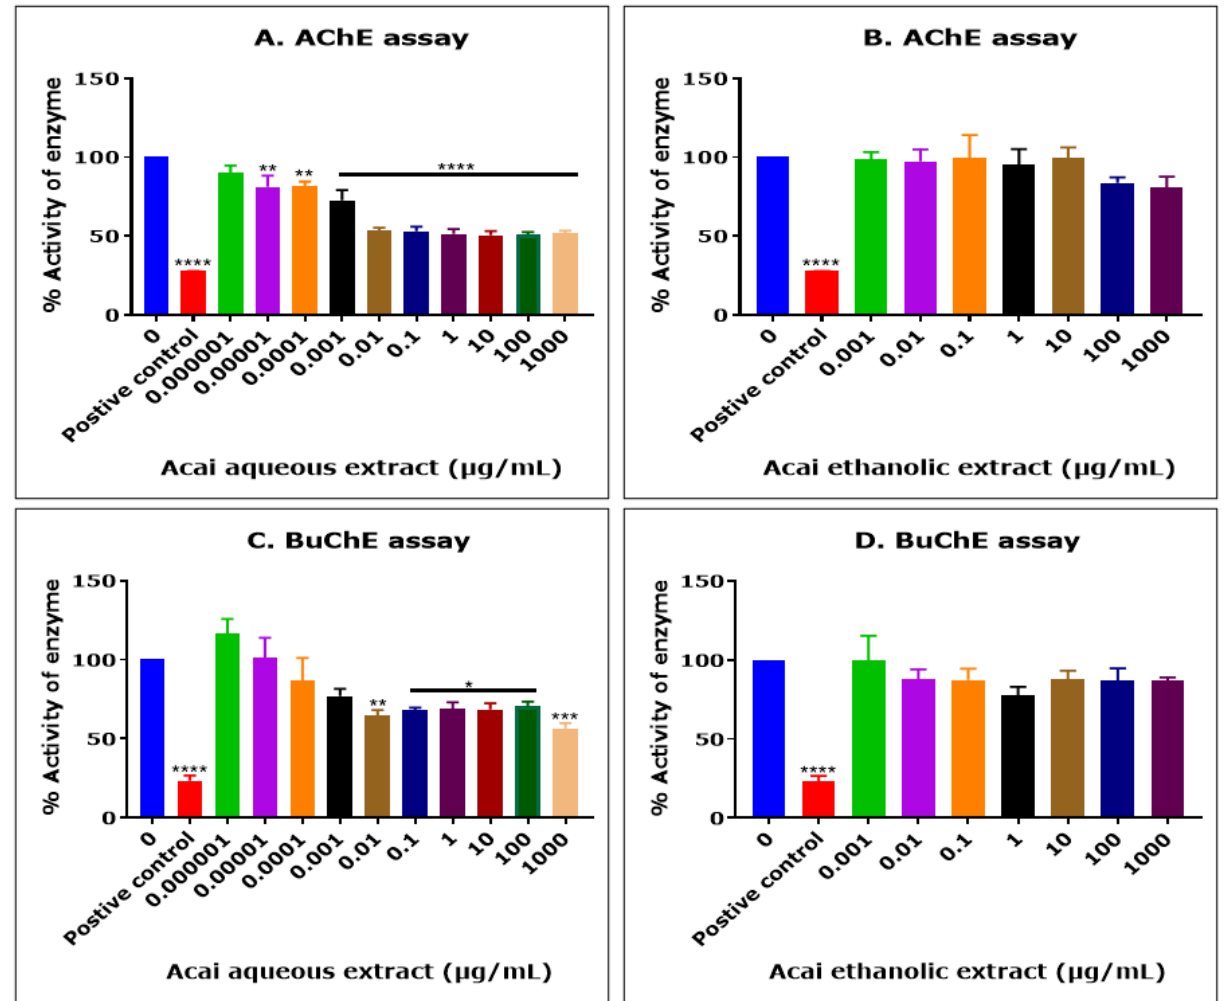
Figure 1. Cholinesterase inhibition by acai aqueous and ethanolic extracts. AChE inhibitory activity of acai aqueous extract ( A ) and acai ethanolic extract ( B ). BuChE inhibitory activity of acai aqueous extract ( C ) and acai ethanolic extract ( D ). Histograms represent means ± SEM for at least three replicate assays at each extract concentration ( n = 6). For the positive control inhibitors, 5 mM azamethiphos and 5 mM ethopropazine hydrochloride were used for AChE and BuChE, respectively. For marked significance * p < 0.05, ** p < 0.01, *** p < 0.001, and **** p < 0.0001.